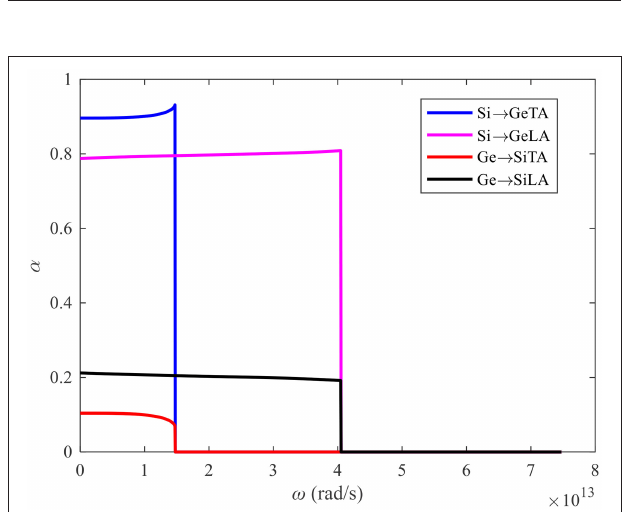
FIGURE 8 | Schematic of the four-layer system with material collocation 1(Si) and 2(Ge): the three interfaces from left to right are denoted as 1st, 2nd, and 3rd interface, respectively.